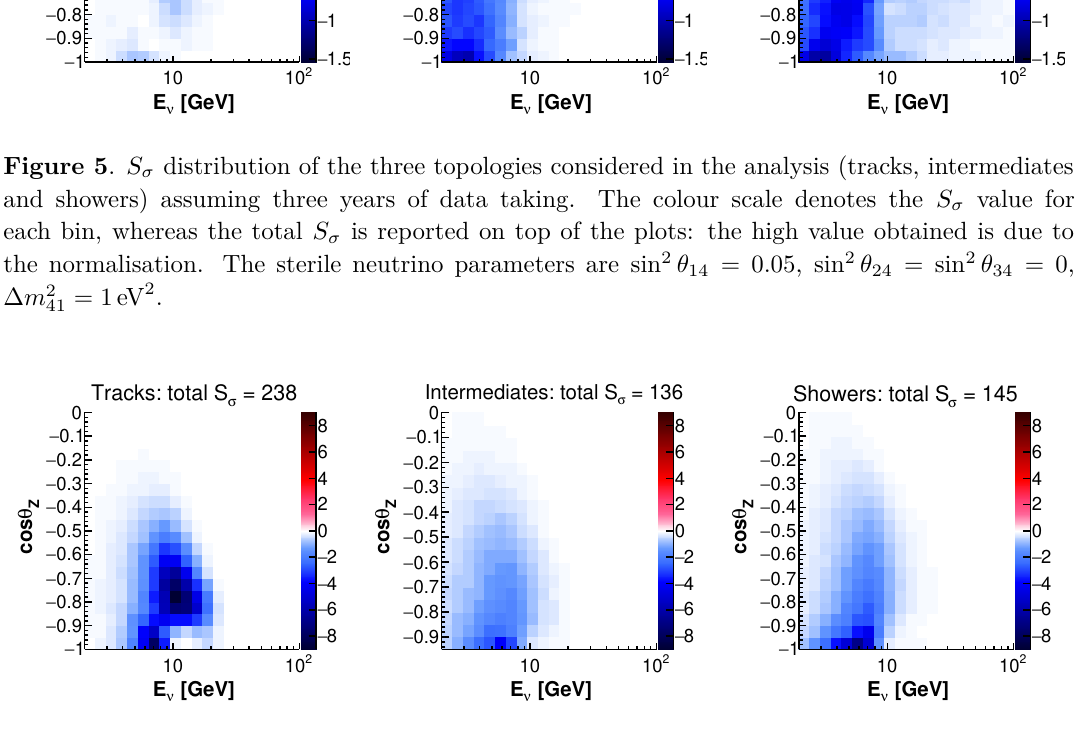
Figure 6 . S σ distribution of the three topologies considered in the analysis (tracks, intermediates and showers) assuming three years of data taking. The colour scale denotes the S σ value for each bin, whereas the total S σ is reported on top of the plots: the high value obtained is due to the normalisation. The sterile neutrino parameters are sin 2 θ 14 = sin 2 θ 24 = sin 2 θ 34 = 0 . 01 , ∆ m 2 = 10 − 4 eV 2 41